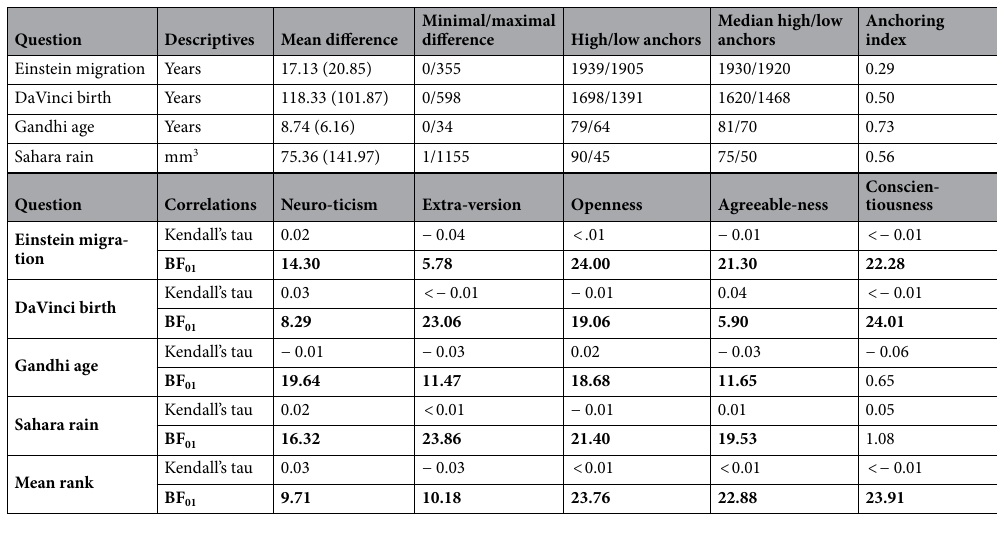
Table 1. Descriptive differences between estimates and anchors and Bayesian Kendall’s tau correlations of rank differences and personality traits. BF 01 displays how many times more likely the nonexistence of a relationship for the depicted Kendall tau correlation is. Bold fonts highlight BFs exhibiting at least moderate evidence against a relationship. Anchoring index values range from 0 (no anchor effects) to 1 (median estimates coincide with